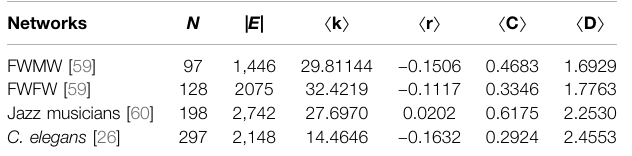
TABLE 1 | The statistical properties of four synthetic networks. TABLE 2 | The statistical properties of four empirical